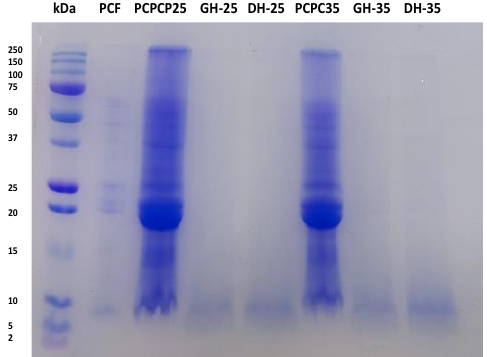
Figure 1. Analysis of profile protein of PCF, PCPC25, PCPC35 and hydrolysates (GH25, DH25, GH35 and DH35) by electrophoresis SDS-PAGE. PCF (purple corn flour), PCPC25 (purple corn protein concentrate germinated for 5 days at 25 ◦ C), PCPC35 (purple corn protein concentrate germinated for 5 days at 35 ◦ C). GH25 (gastric hydrolysate of PCPC25), DH25 (duodenal hydrolysate of PCPC25), GH35 (gastric hydrolysate of PCPC35) and DH35 (duodenal hydrolysate of PCPC35).